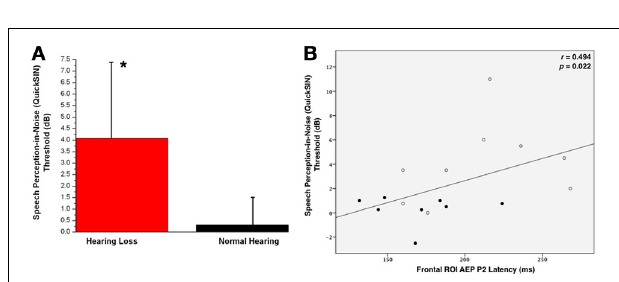
yellow (yellow is highest level of activation), and the Montreal Neurological Institute (MNI) coordinates are listed below each MRI slice. (B) A table describing activated anatomical cortical areas for the CAEP components for each group, listed in approximate order of highest level of activation.